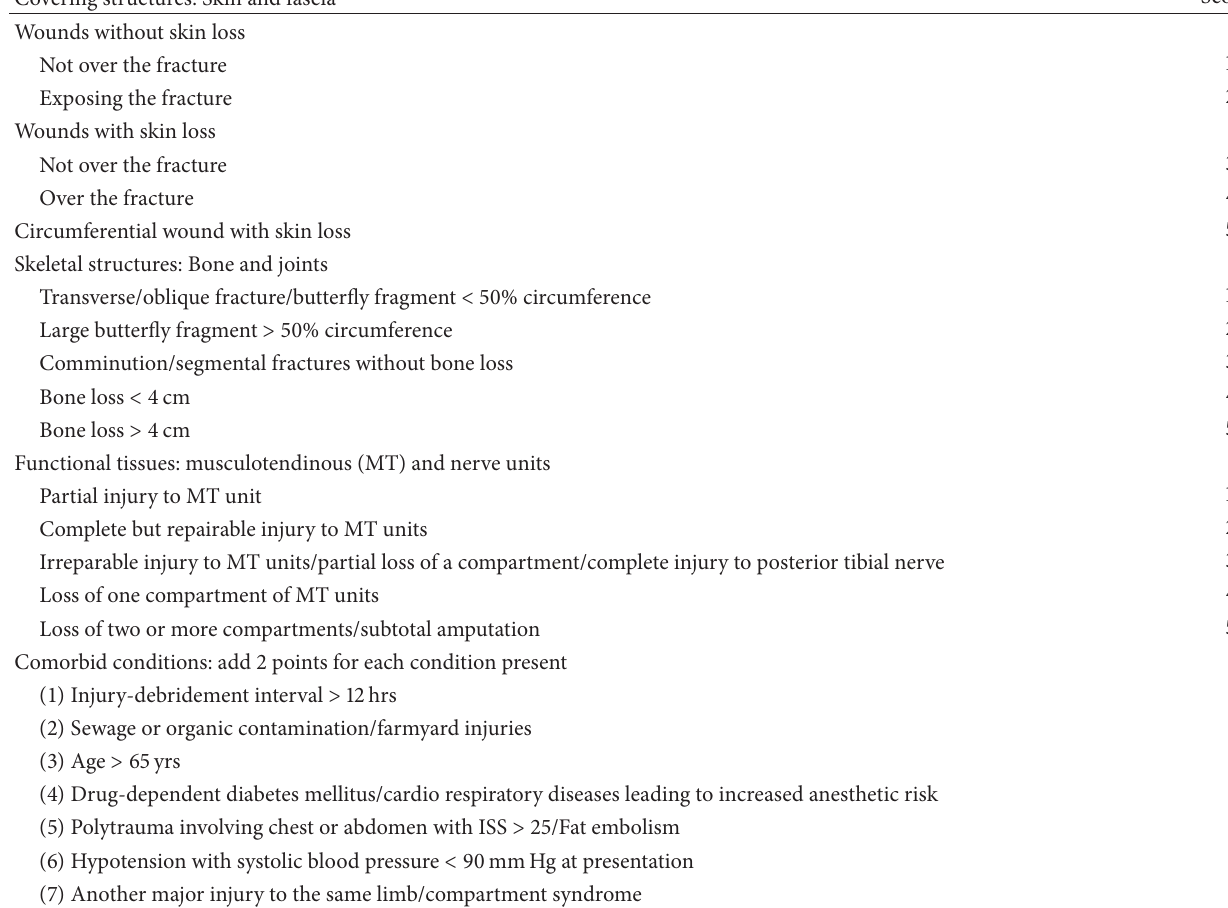
Table 2: Ganga hospital open injury severity